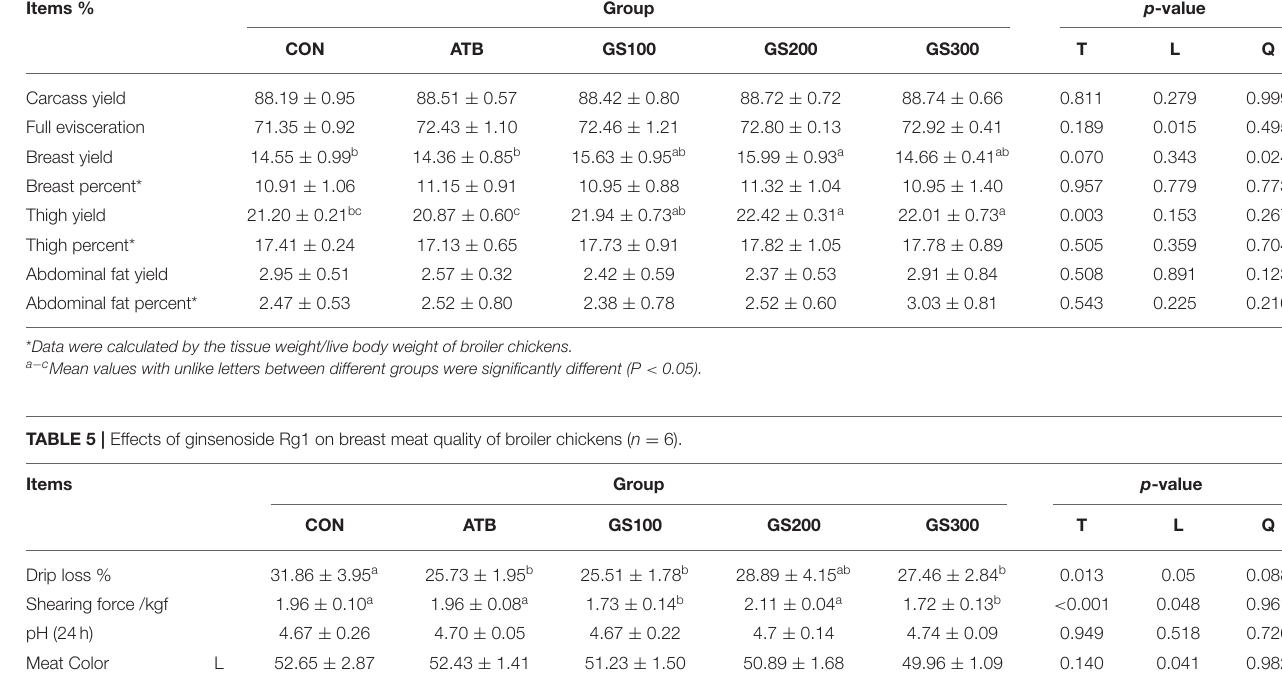
TABLE 4 | Effects of ginsenoside Rg1 on carcass traits of broiler chickens ( n = 6). Items % Group